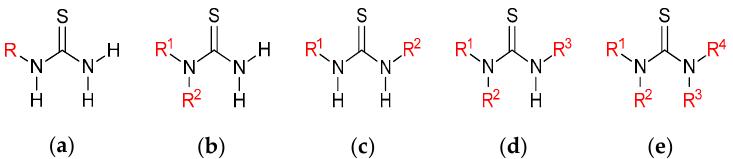
Figure 1. Types of thioureas; ( a ) monosubstituted; ( b ) 1,1-disubstituted; ( c ) 1,3-disubstituted; ( d ) trisubstituted; ( e ) tetrasubstituted.